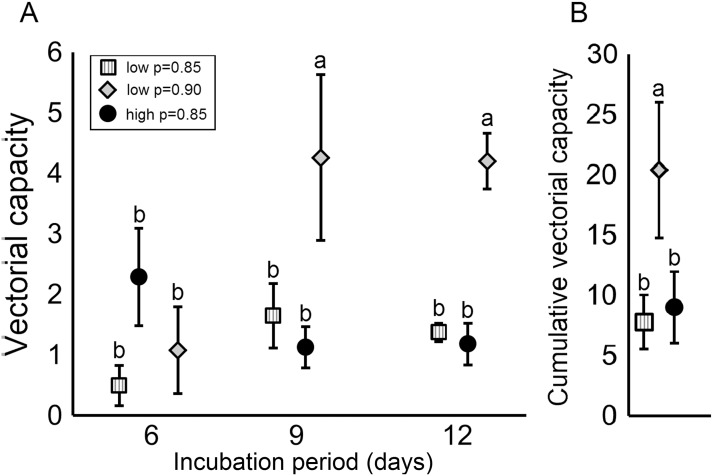
Effect of larval competition on vectorial capacity.Panel A displays the vectorial capacity values for high and low density treatments at the 6, 9, and 12-day incubation periods. Panel B displays the cumulative vectorial capacity for high and low-density treatments. Tests of significance were corrected for multiple comparisons using the Tukey-Kramer adjustment. Different letters indicate significant differences in means.